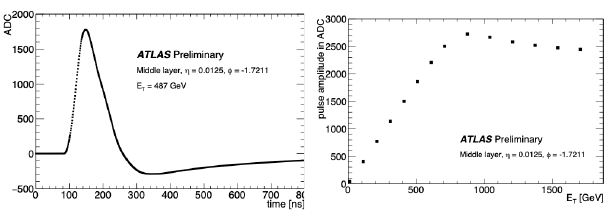
Figure 8: Calibration data read from the Phase-I trigger path [11]. The plot on the left shows the measured pulse shape of a SC in EMBA, obtained from delay run with an injected charge of DAC = 4400 (cor- responding to a transverse energy of 487 GeV). The plot on the right shows the measured amplitude (ADC) of calibration pulses as a function of injected charge (DAC) from a ramp run for this same